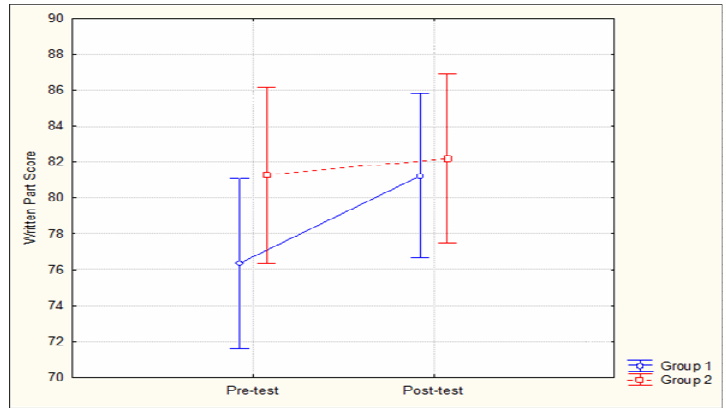
Figure 1. Written Part pre-test and post-test scores for both groups. 3